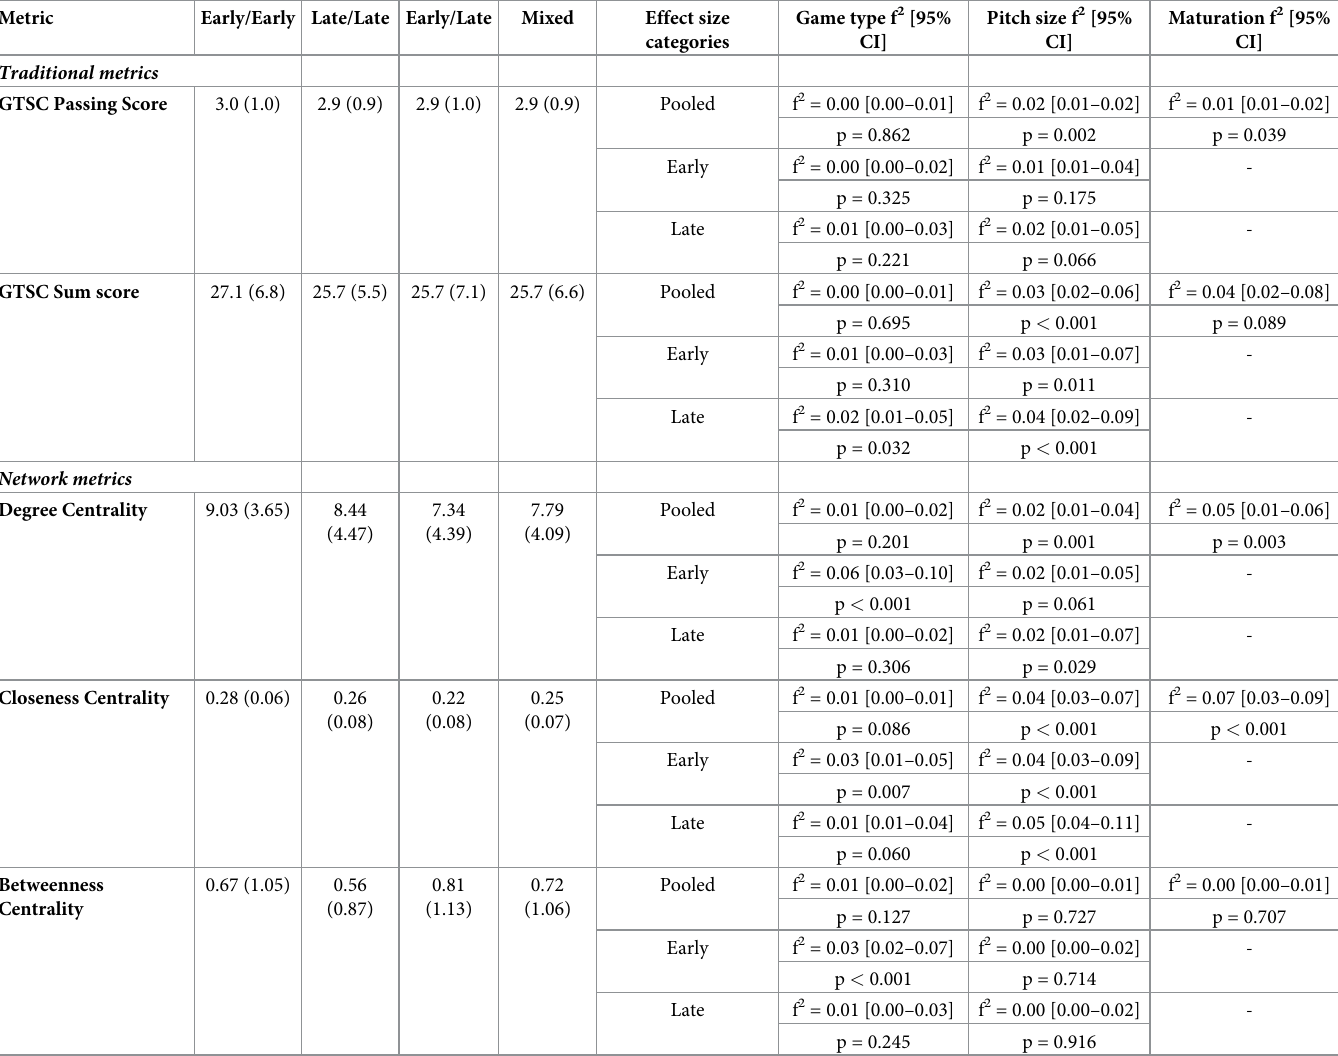
Table 2. Individual-based traditional and network passing metrics and the effects of game type, pitch size and maturation.